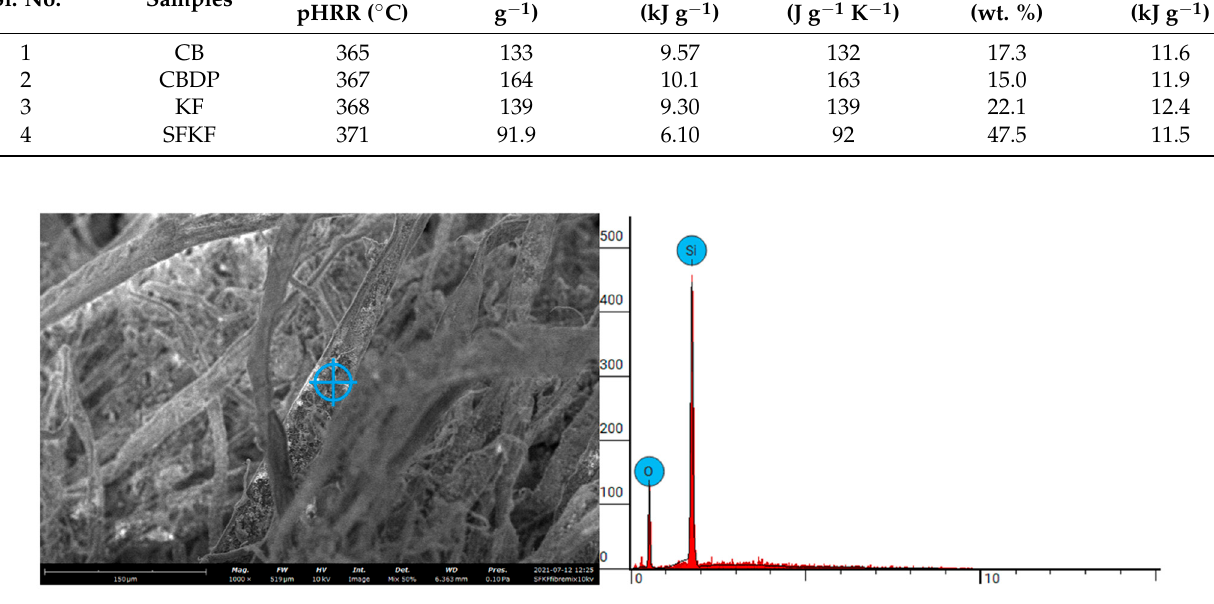
Figure 5. SEM/EDS report of SF on fibre .